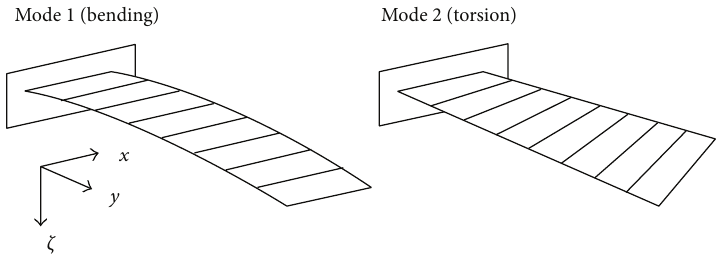
Figure 1: The two deflection patterns assumed for the flexible